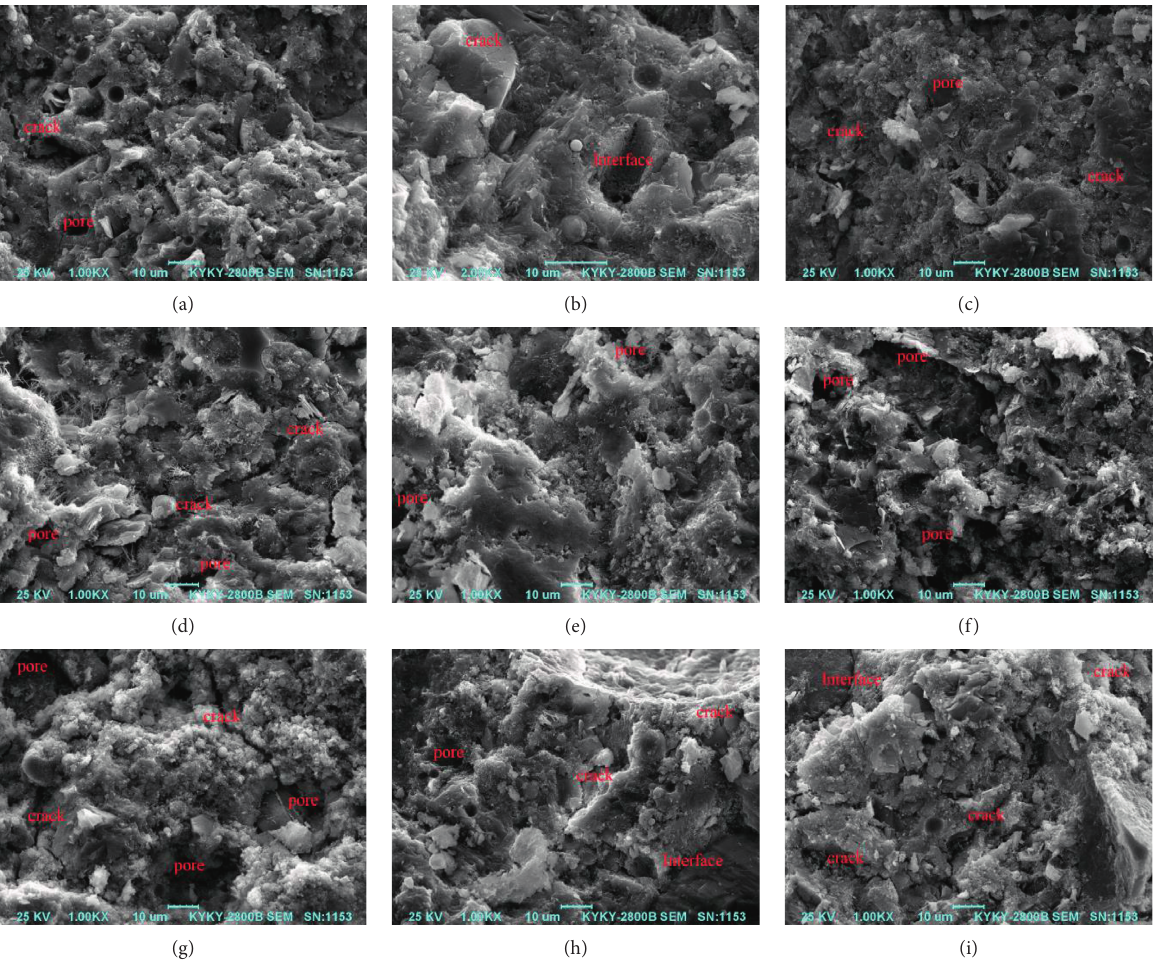
Figure 24: SEM of DSC after elevated temperatures. (a) Room temperature, DSRR-0%. (b) Room temperature, DSRR-60%. (c) Room temperature, DSRR-100%. (d) 300 ° C, DSRR-0%. (e) 300 ° C, DSRR-60%. (f) 300 ° C, DSRR-100%. (g) 700 ° C, DSRR-0%. (h) 700 ° C, DSRR-60%. (i) 700 ° C, DSRR-100%.